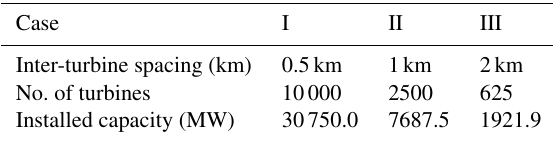
Table 2. Wind farm layout